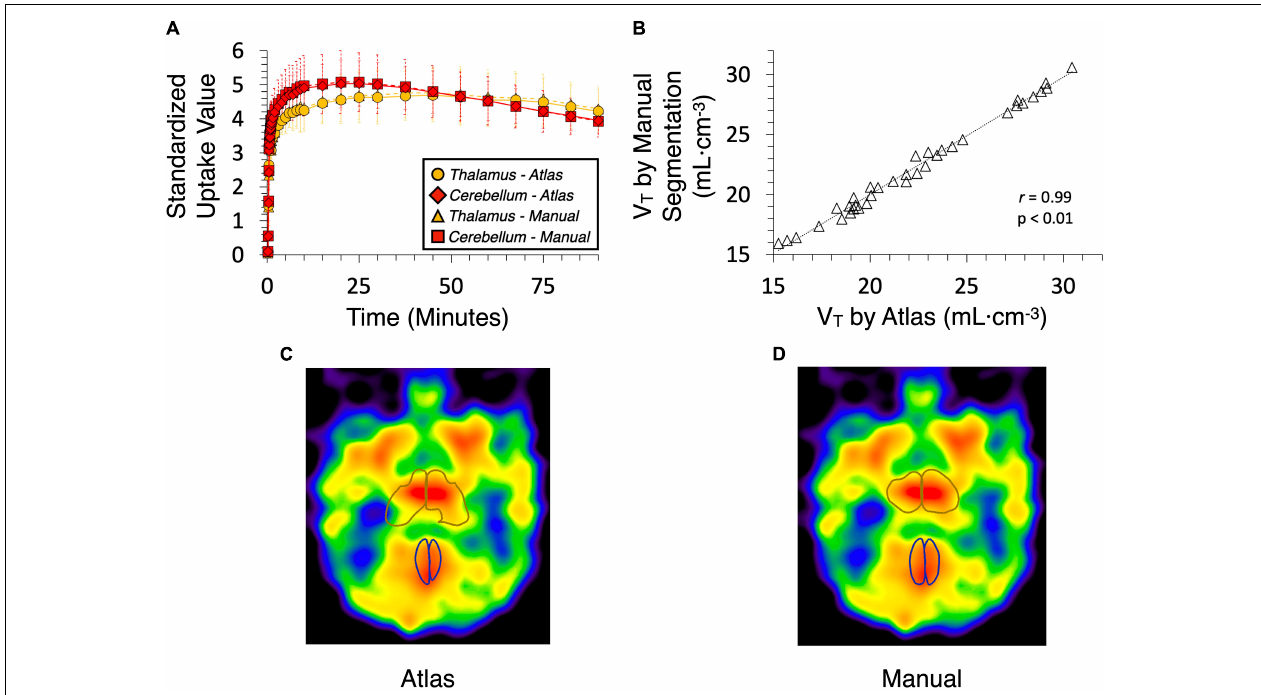
FIGURE 5 | Time-activity curves (TAC) and volumes of distribution (V T ) generated from dynamic [ 11 C]benzamide data by baboon atlas and manual segmentation using the human brain template on PMOD. (A) TAC was obtained from the thalamus and cerebellum. (B) Correlation curve of V T ( r = 0.99, P < 0.01). (C) Thalamus and cerebellum are defined by the atlas. (D) Thalamus and cerebellum are defined